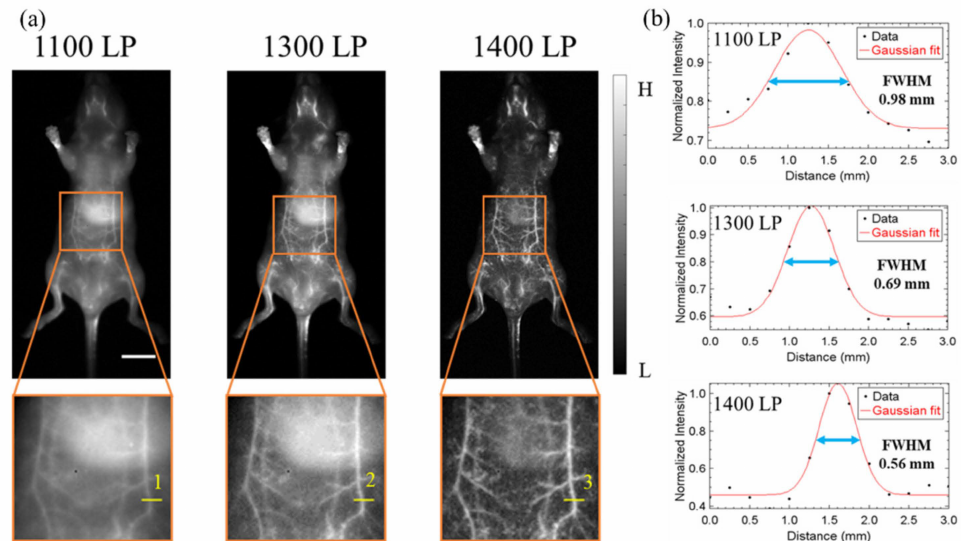
Figure 4. In vivo NIR-II whole-body fluorescence imaging of nude mice in supine positions ( a ) NIR-II bioimaging of mice after intravenous injection of IR-TPE Pdots (n = 3) with different LP filters (scale bar, 10 mm). ( b ) Fluorescence intensity signals (black points) and Gaussian fitting curve (solid red line) along yellow lines 1–3 in the NIR-II fluorescence image are shown in ( a